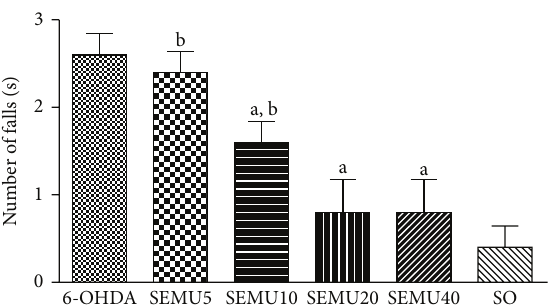
Figure 2: Effects of the standardized extract from M. urundeuva (SEMU) on the rotarod test, in a rat model of Parkinson’s disease. SEMU (5, 10, 20, and 40 mg/kg, p.o.) was administered, 1h after the stereotaxic surgery (unilateral injection of 6-OHDA into the right striatum) and daily for 14 days. The animals were placed upon a spinning bar (12rpm), and the number of falls was determined for 1min. The values are means ± SEM from 5 animals per group. (a) 𝑃 < 0.01 versus 6-OHDA and (b) 𝑃 < 0.001 versus SO, respectively (one-way ANOVA and Newman-Keuls as the post hoc test).